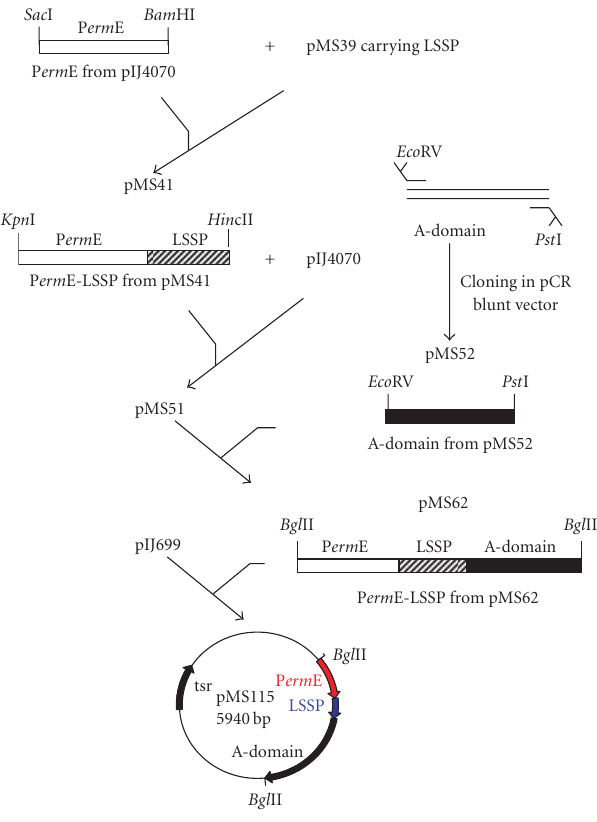
Figure 1: Construction of plasmid pMS115. The constitutive erm E- up promoter from pIJ4070 was subcloned as a Sac I- Bam HI frag- ment in the pMS39 plasmid carrying the long synthetic signal pep- tide (LSSP) giving the pMS41 plasmid. Then the Kpn I- Hin cII frag- ment carrying P erm E-up-LSSP from pMS41 was cloned in pIJ4070 yielding the pMS51 plasmid. PCR product of the rat CD11b A- domain was cloned into the pCR-Blunt vector to produce the pMS52 plasmid. The fragment E coR V- Pst I corresponding to the A- domain from pMS52 was cloned in pMS51 giving the pMS62 plas- mid. Finally, the Bgl II fragment from pMS62 carrying the cassette “P erm E-up-LSSP-A-domain” was cloned in the pIJ699 vector